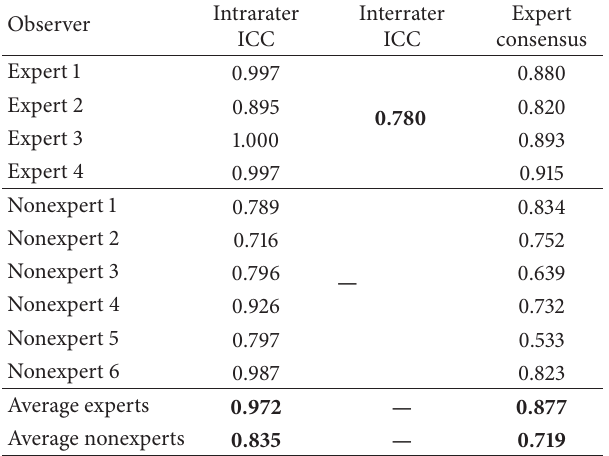
Table 4: Cross-classifications of both gradings given by 6 non- experts are calculated for 50 swallows: the pattern of agreement (diagonal) and the total frequency of assigned scores for gradings 1 and 2 are